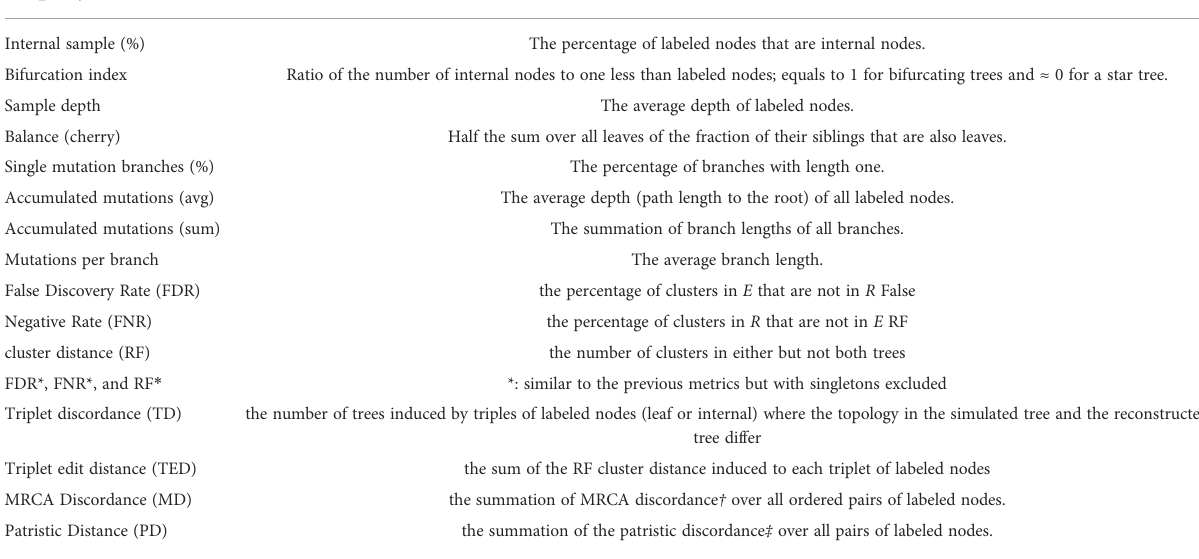
TABLE 4 Clonal tree properties and metrics for comparing the reference tree R to estimated tree E .